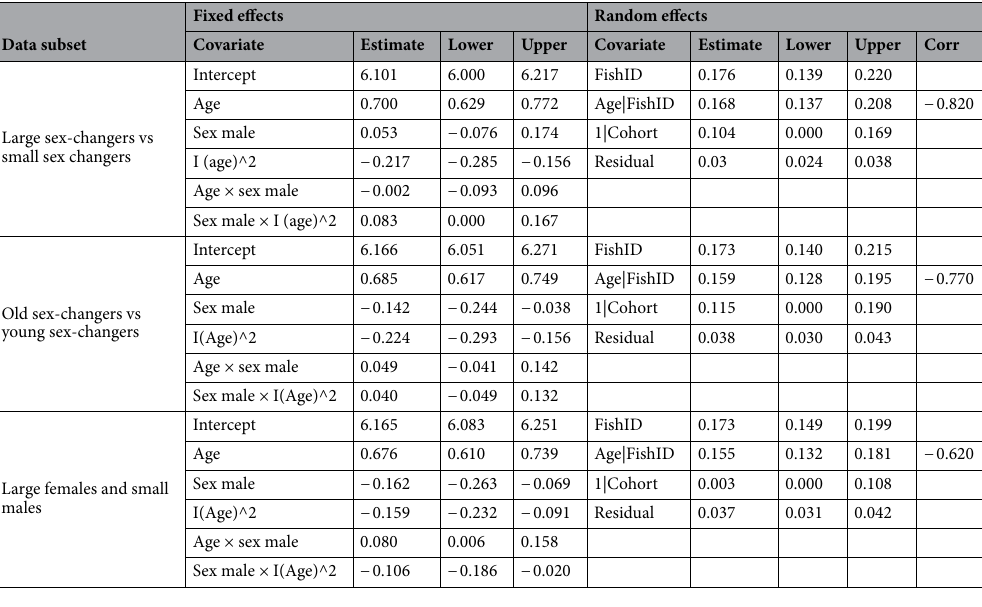
Table 2. Model parameter estimates with 95% CI describing fixed and random sources of growth variation in barramundi among each comparison of life-history